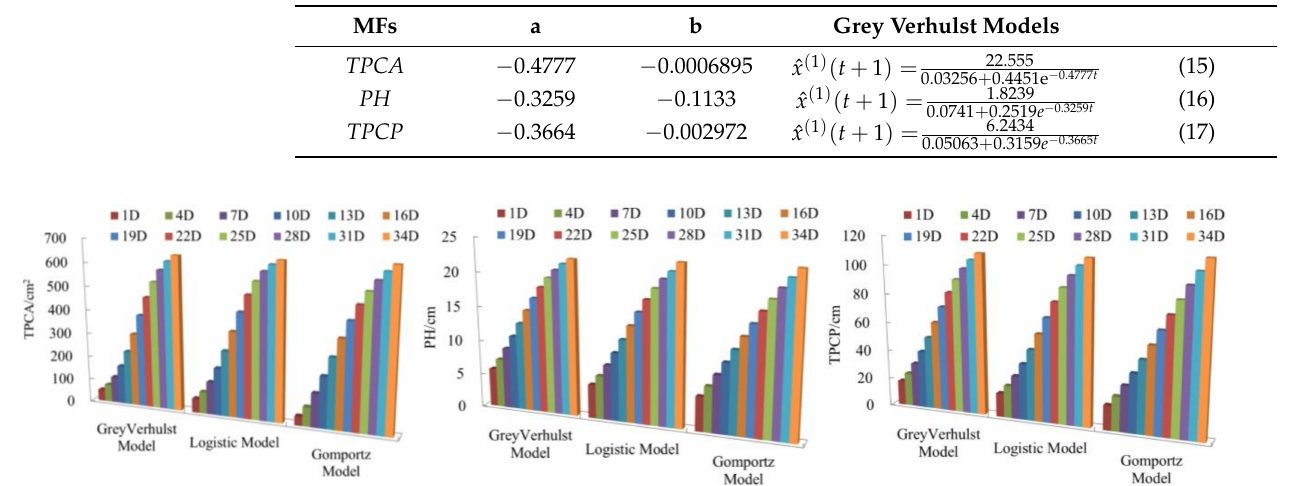
Table 2. The grey Verhulst prediction models for TPCA , PH and TPCP .